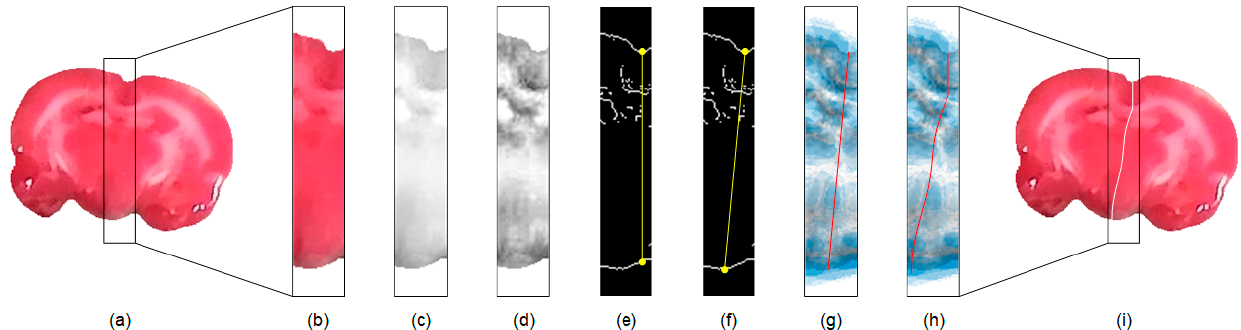
Figure 2. Illustration of the proposed rat hemisphere segmentation algorithm. ( a ) Extracted rat brain slice. ( b ) Segmented medial subimage from ( a ). ( c ) Red channel image S r of ( b ). ( d ) Enhanced image S c of ( c ). ( e ) Edge map S e of ( d ). ( f ) Initial straight midline connecting the brain boundaries. ( g ) Initial midline superimposed on the GVF field. ( h ) Estimated midline after curve evolution. ( i ) Final midline superimposed on the input image for separation.